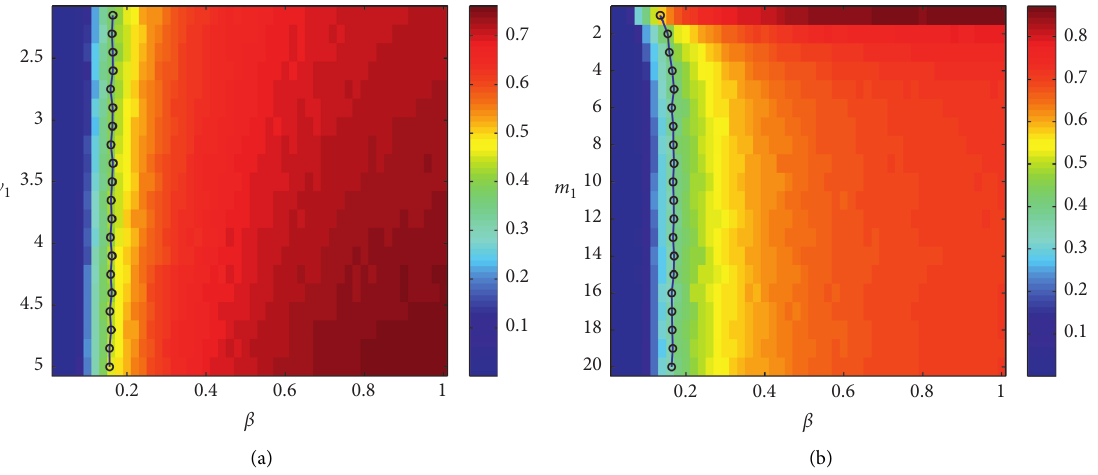
Figure 6: The final fractions ρ I and ρ N of the infected nodes and the noresource nodes as a function of activity potential capacity m i . The symbols are the same as those in Figure 3. The upper panel presents that ρ I and ρ N changes with c resource layer, which shows that stronger activity heterogeneity and larger contact capacity of individuals in the resource layer can effectively promote resource diffusion but suppress epidemic spreading. The lower panel presents that ρ I and ρ N changes with c epidemic layer, which suggests that these two characters of individuals in the epidemic layer cause more resource depletion and thus promote epidemic spreading. The other fixed parameters are δ � 0.10, λ � 0.64, β � 0.70, μ � 0.48, and m � 2.5 for (b), (c), and (d); and c � 2.5 for (a), (b), and (a), (b), and (c); c 1 2